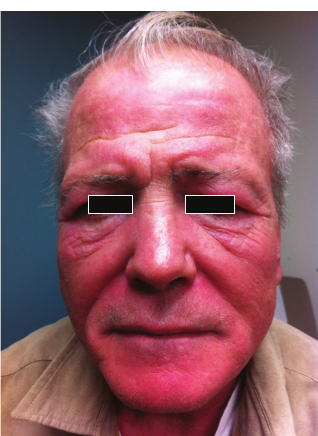
Figure 2: Cutaneous mucinosis: diffuse erythematous, violaceous rash of the face.